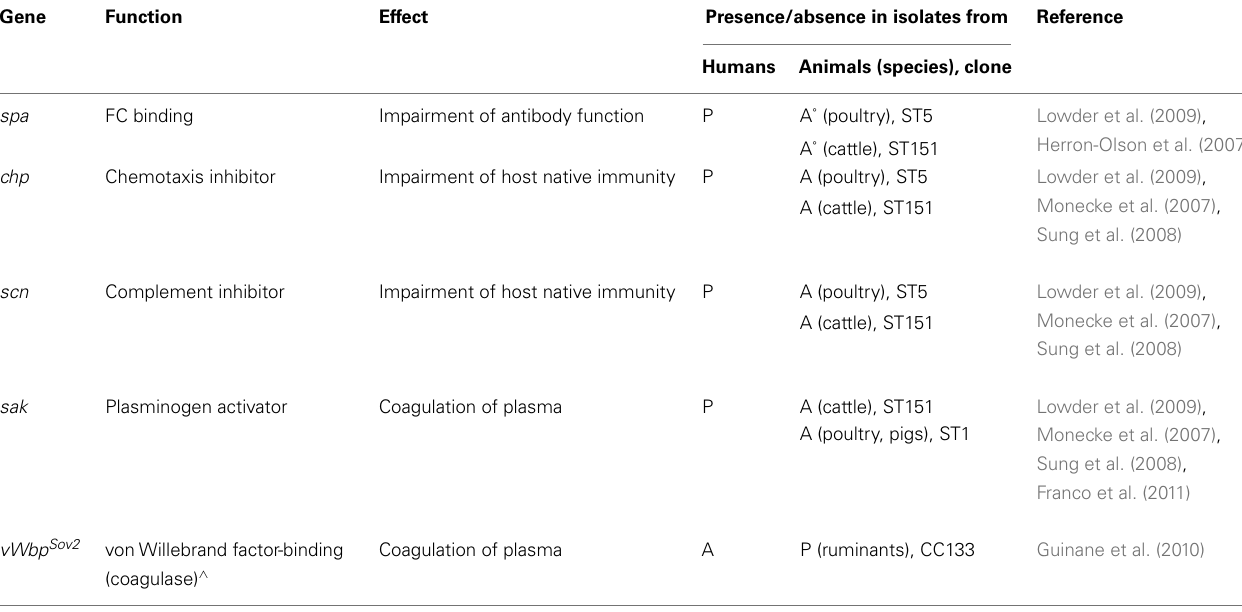
Table 1 | Distribution of some S. aureus genes among human and animal